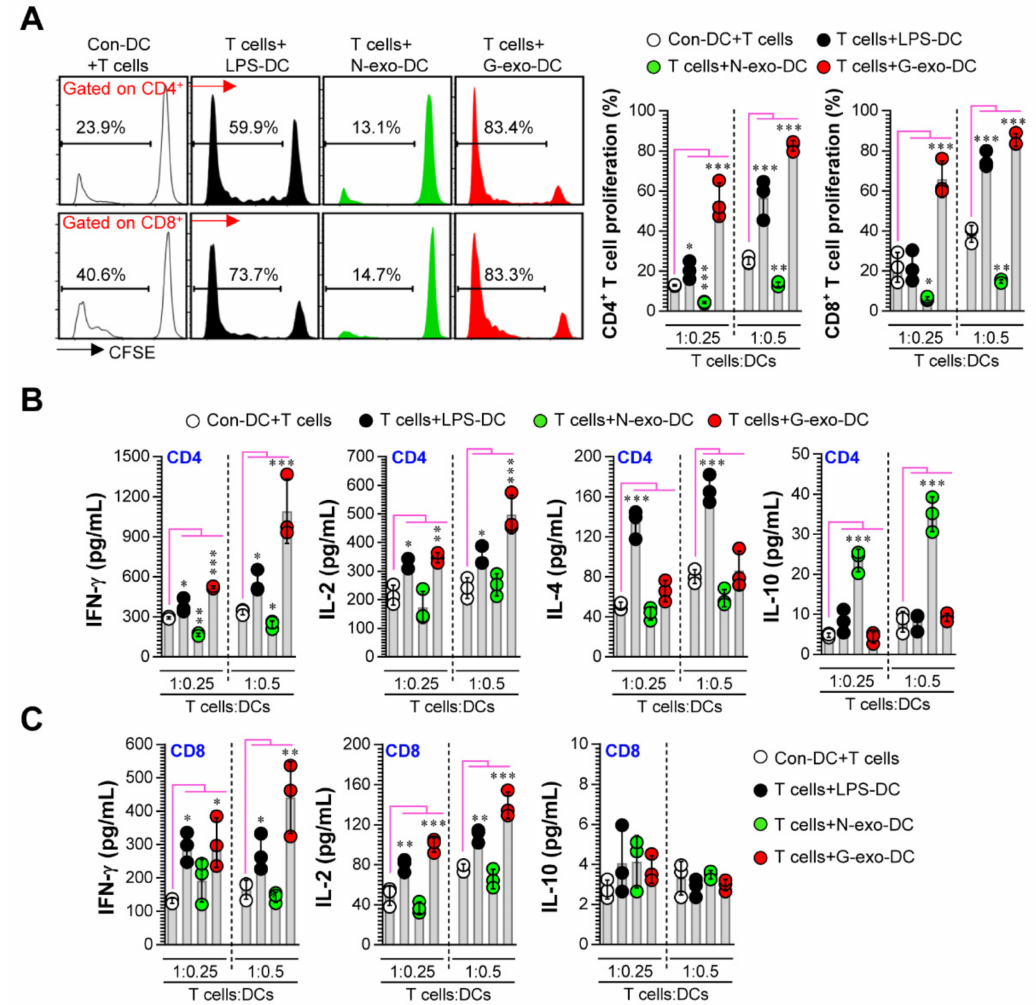
Figure 3. Analysis of proliferation and cytokine production of T cells induced by N-exo- and G-exo-stimulated DCs in the allogenic MLR assay. ( A – C ) Non-, LPS (100 ng / mL)-, N-exo (25 µ g / mL)- and G-exo (25 µ g / mL)-stimulated DCs incubated for 18 h were co-cultured with CFSE-labeled CD4 + and CD8 + T cells for 3 days ( n = 3). ( A ) The proliferation of CD4 + and CD8 + T cells were analyzed using flow cytometry. ( B ) Production of IFN- γ , IL-2, IL-4, and IL-10 were analyzed in culture supernatants co-cultured with CD4 + T cells and DCs using ELISA. ( C ) Production of IFN- γ , IL-2, and IL-10 were analyzed in culture supernatants co-cultured with CD8 + T cells and DCs using ELISA. * p < 0.05, ** p < 0.01, *** p < 0.001. Con-DC: non-treated DC, LPS-DC: LPS-treated DC, N-exo-DC: N-exo-stimulated DC, G-exo-DC: G-exo-stimulated